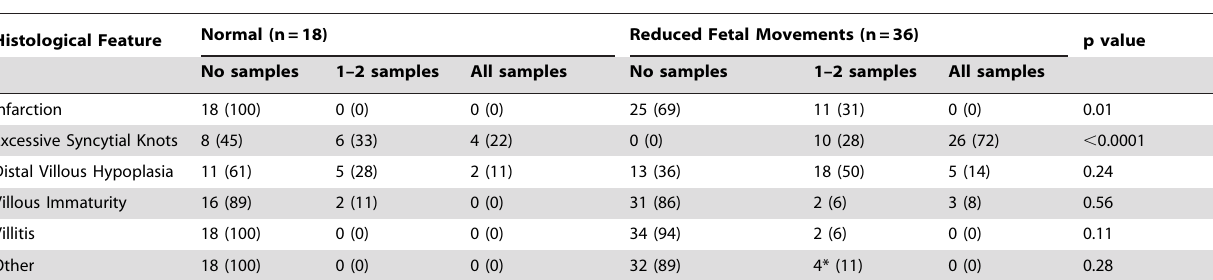
Table 3. Classification of samples on histopathological